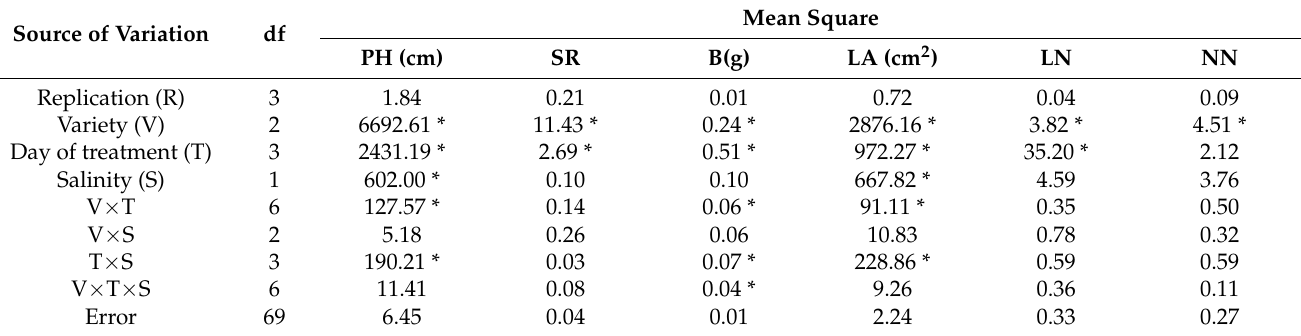
Table 2. ANOVA result of growth